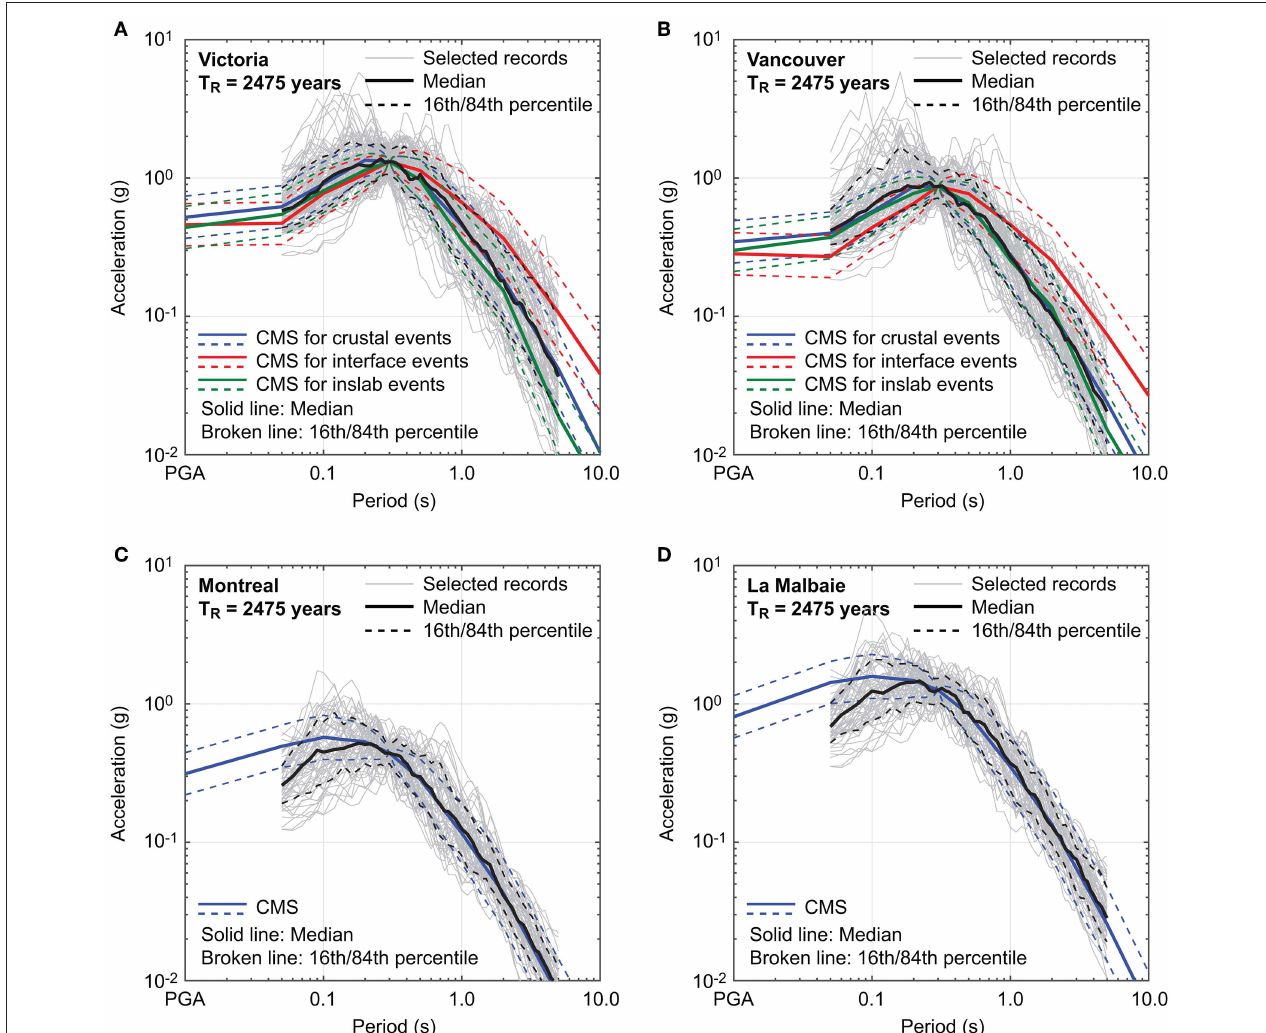
FIGURE 7 | Conditional mean spectrum-based record selection: (A) Victoria, (B) Vancouver, (C) Montreal, and (D) La Malbaie.